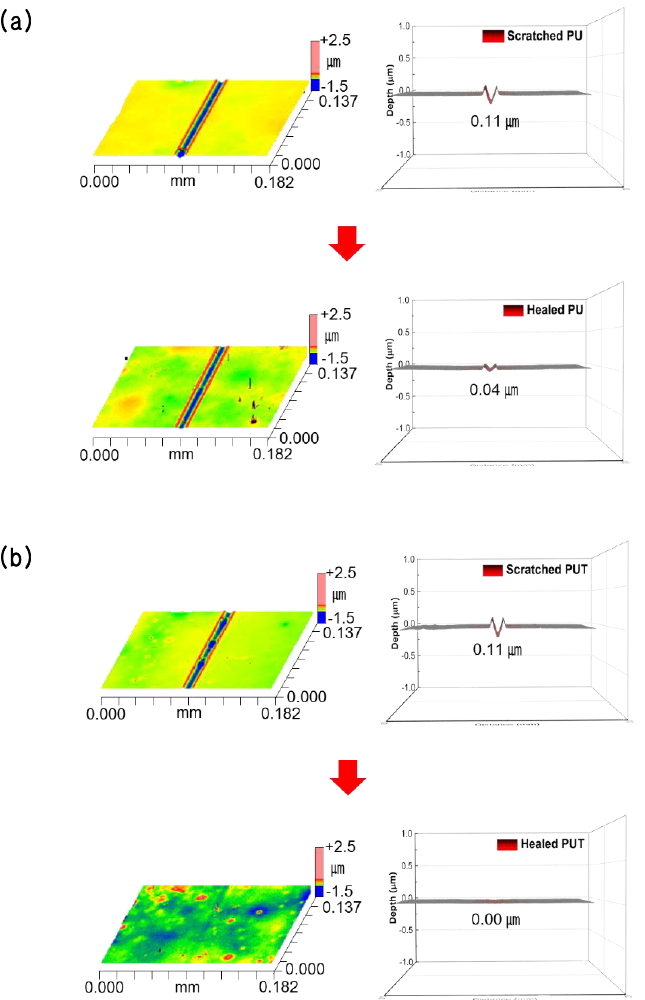
Figure 2. Interferometer images of ( a ) PU and ( b ) PUT before and after the self-healing process. The loading force of 50 mN was applied to both samples and the self-healing temperature and time were set to T g + 10 °C and 10 min, respectively.